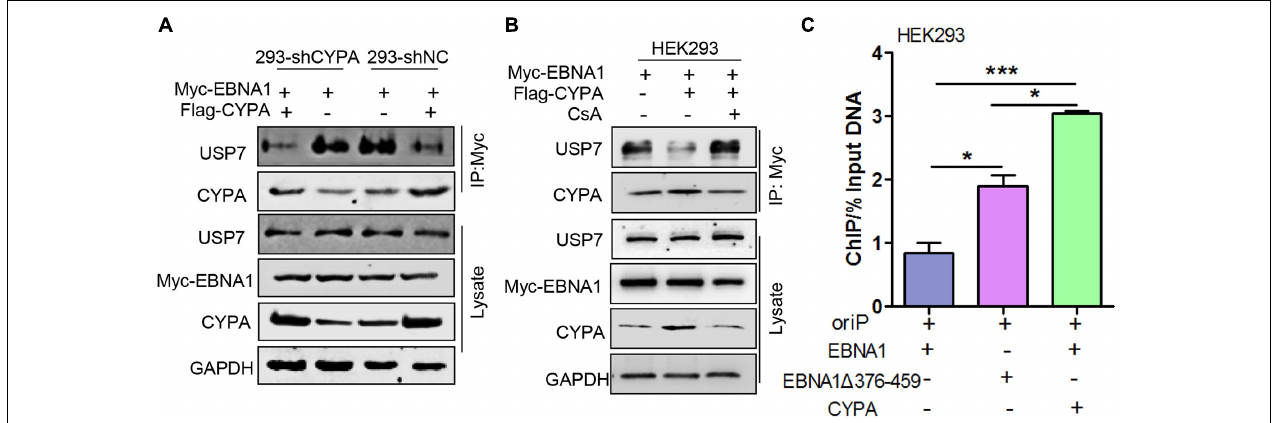
FIGURE 6 | The effect of ectopic CYPA expression on USP7-EBNA1 and EBNA1-oriP binding. (A) Effect of CYPA overexpression on EBNA1-USP7 binding in HEK293-shCYPA and HEK293-shNC cells. These cells were transiently transfected with pCAGGS-Flag-CYPA alone or with pCAGGS-Myc-EBNA1, a co-IP assay was performed with the anti-Myc antibody for the pulldown. (B) The inhibition of CsA on CYPA-USP7 antagonism in the binding with EBNA1. pCAGGS-Myc-EBNA1 was transfected with pCAGGS-Flag-CYPA or alone, and treated with CsA. The anti-Myc antibody was used for the pulldown, and proteins were detected by WB. (C) Effect of CYPA overexpression and EBNA1 (cid:49) 376-459 mutation on the EBNA1-oriP binding detected by ChIP assay. ∗ P < 0.05, ∗∗∗ P < 0.001.